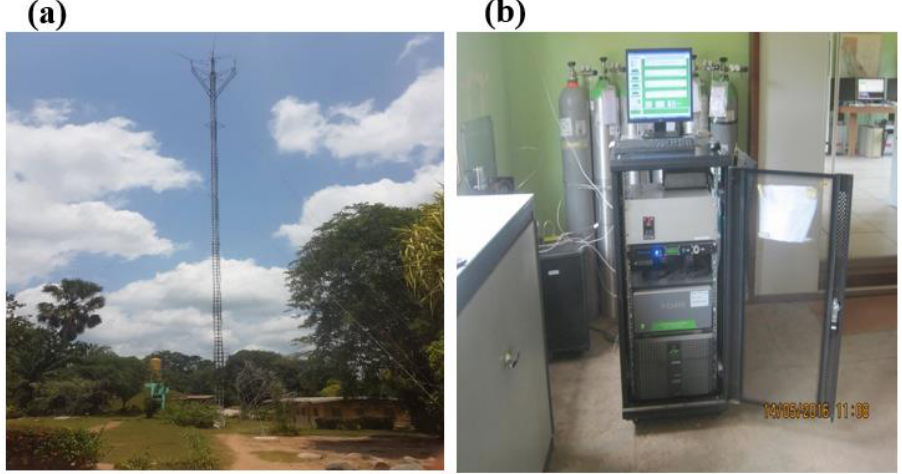
Figure 3. Photo ( a ) of the 50 m high tower and ( b ) of the measurement system “PICARRO G2401”.